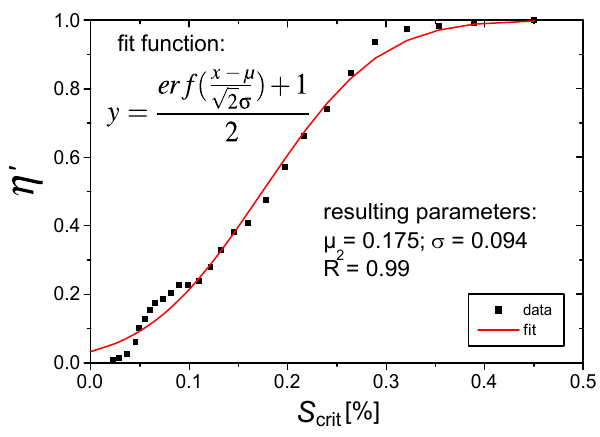
Fig. 7. Activated fraction η 0 as function of critical supersaturation S crit (squares). Red line denotes a fitted error function.